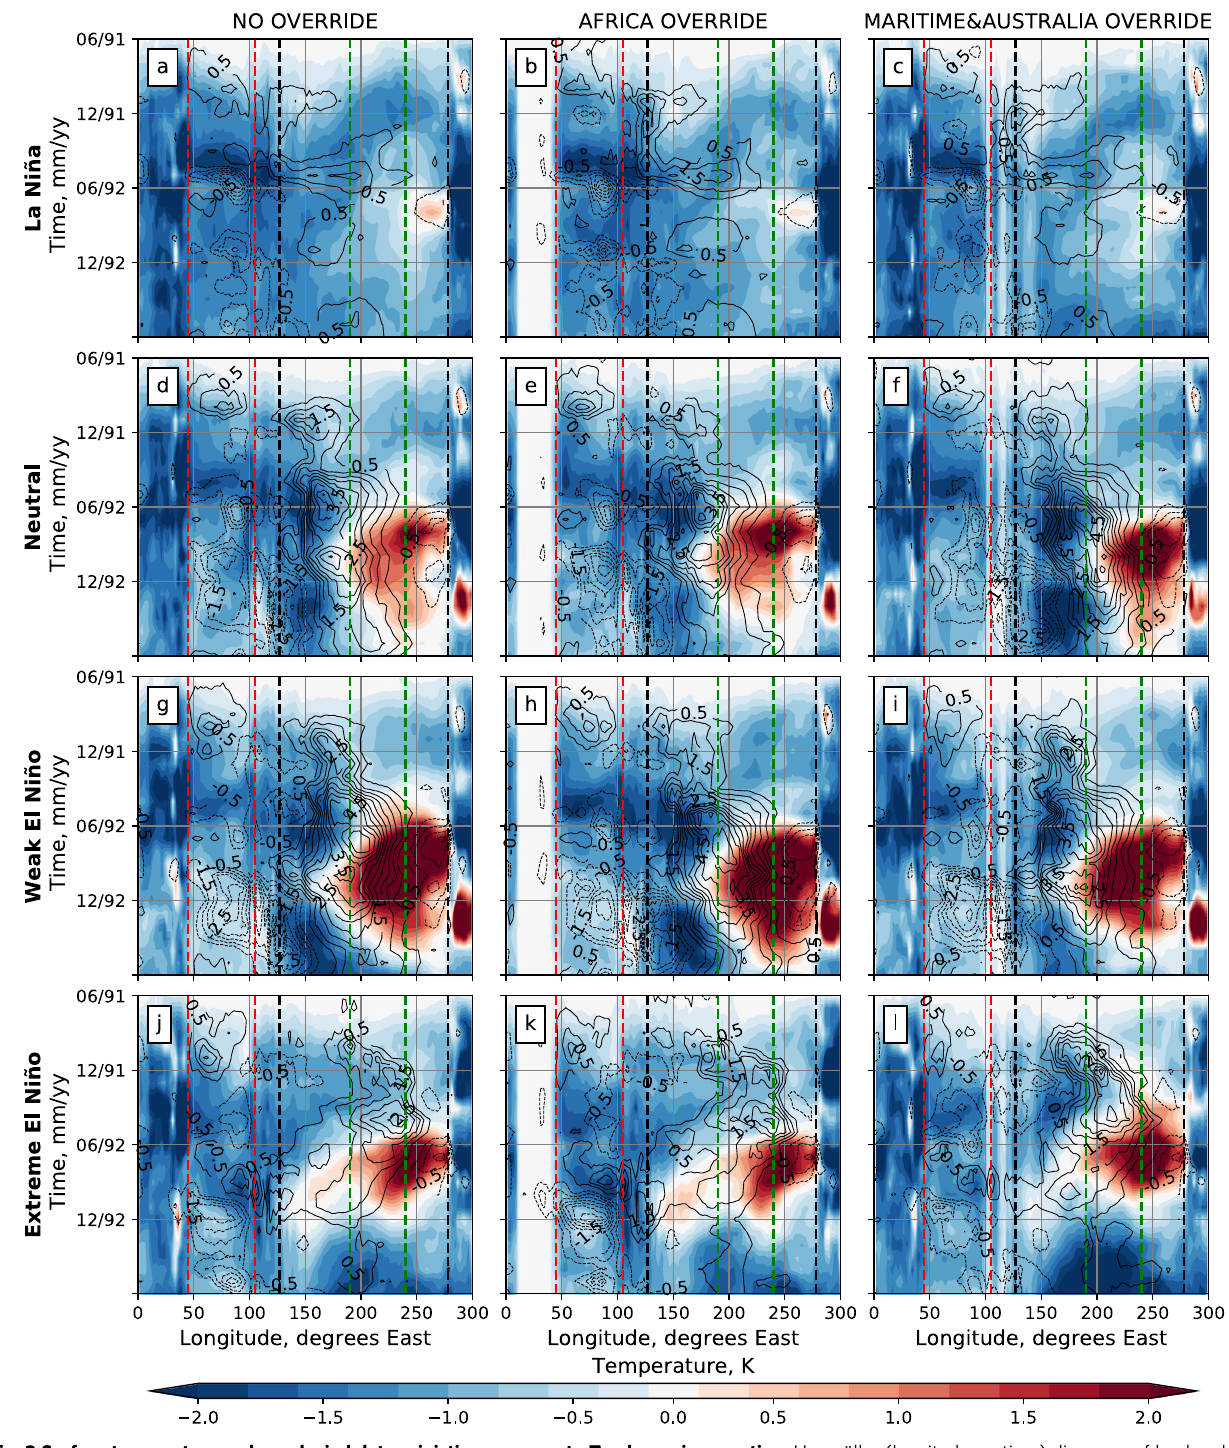
Fig. 3 Surface temperature and zonal wind deterministic responses to Tambora-size eruption. Hovmöller (longitude vs. time) diagrams of land and sea surface temperature responses (K, shaded) and zonal wind deterministic response (m/s, black contours every 0.5 m/s) to a June 1991 Tambora-size eruption, averaged 5 ∘ S-5 ∘ N during June 1991 – June 1993. The response is calculated as the Tambora grand-ensemble median minus the Butter fl y grand- ensemble median, for experiments without continental temperature override (left column) and with temperature override over Africa (middle column) and the Maritime&Australia continents (right column). Rows indicate responses of La Niña ( a – c ), Neutral ( d – f ), weak El Niño ( g – i ), and extreme El Niño ( j – l ) onsets (see Experimental setup for event de fi nitions). Medians are calculated from 100-member grand-ensembles for the experiments without override, and 50-member grand-ensembles for the experiments with override (Table 4). Dashed lines bound the Indian ocean (red), Paci fi c ocean (black), and Niño3.4 region